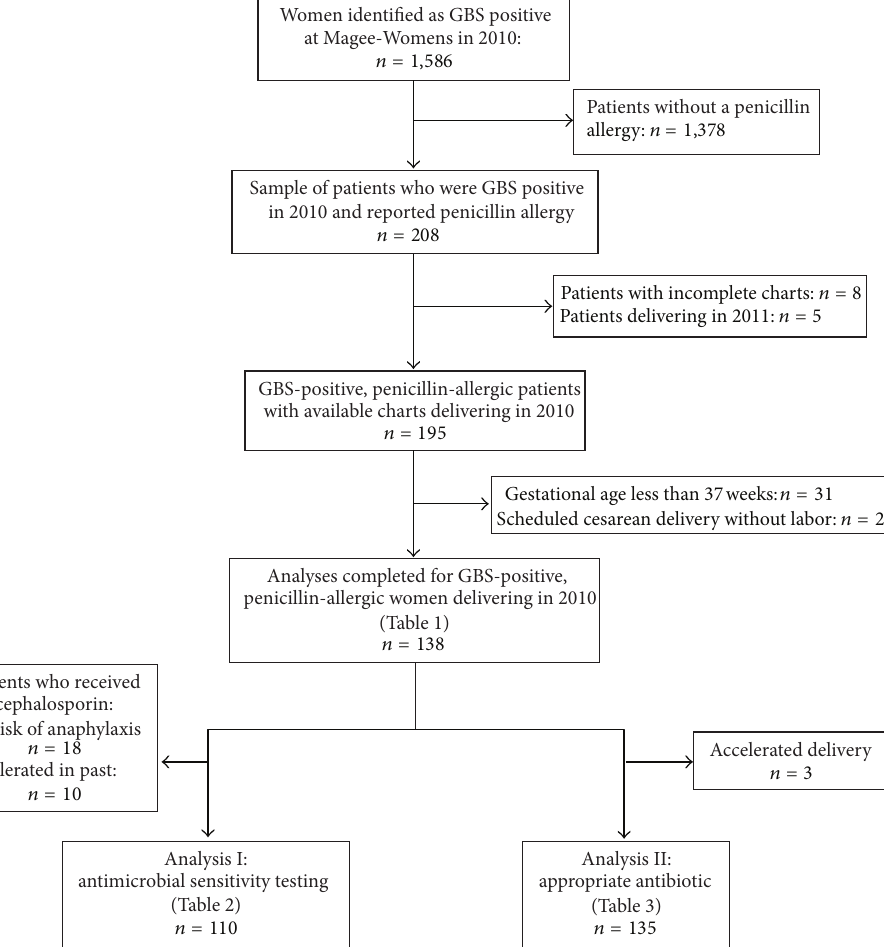
Figure 1: Flow Chart of Patient